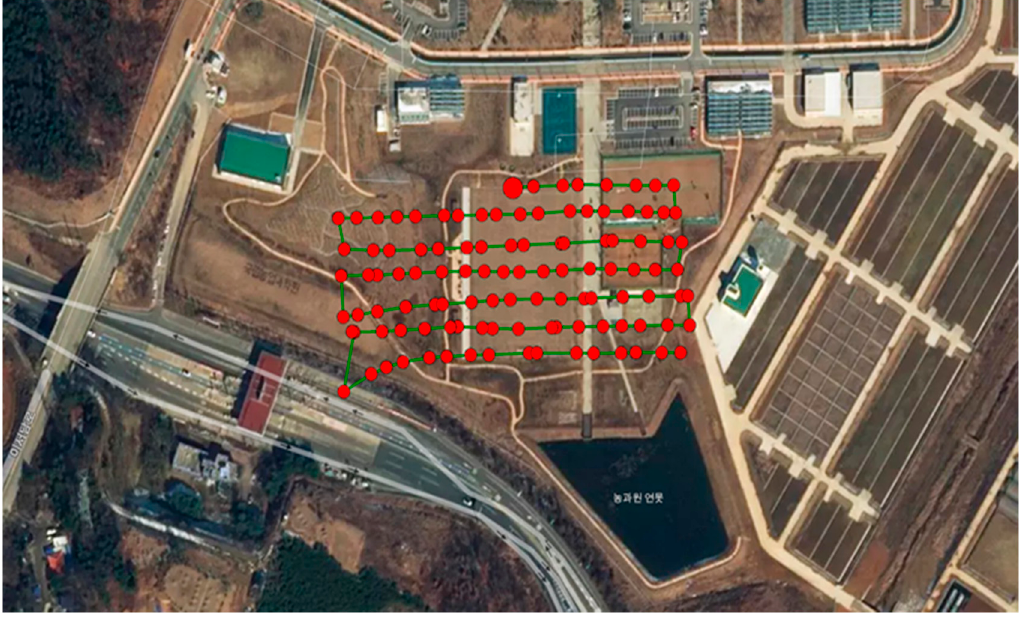
Figure 1. Flight trajectory of the UAV (green line) and the locations of the images acquired (red dots).